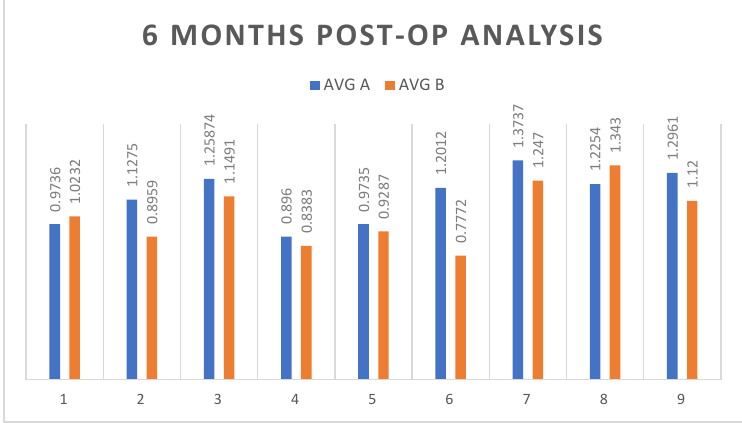
Figure 7. Discrepancy values of nine medial orbital wall points between immediately post treatment affected orbit image and affected orbit at 6 months post treatment for Group A compared with Group B.